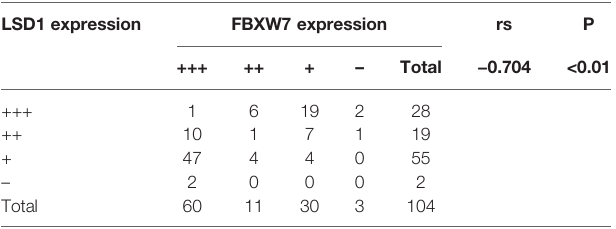
TABLE 2 | Correlation analysis between LSD1 and FBXW7 immunoreactivity in PCa